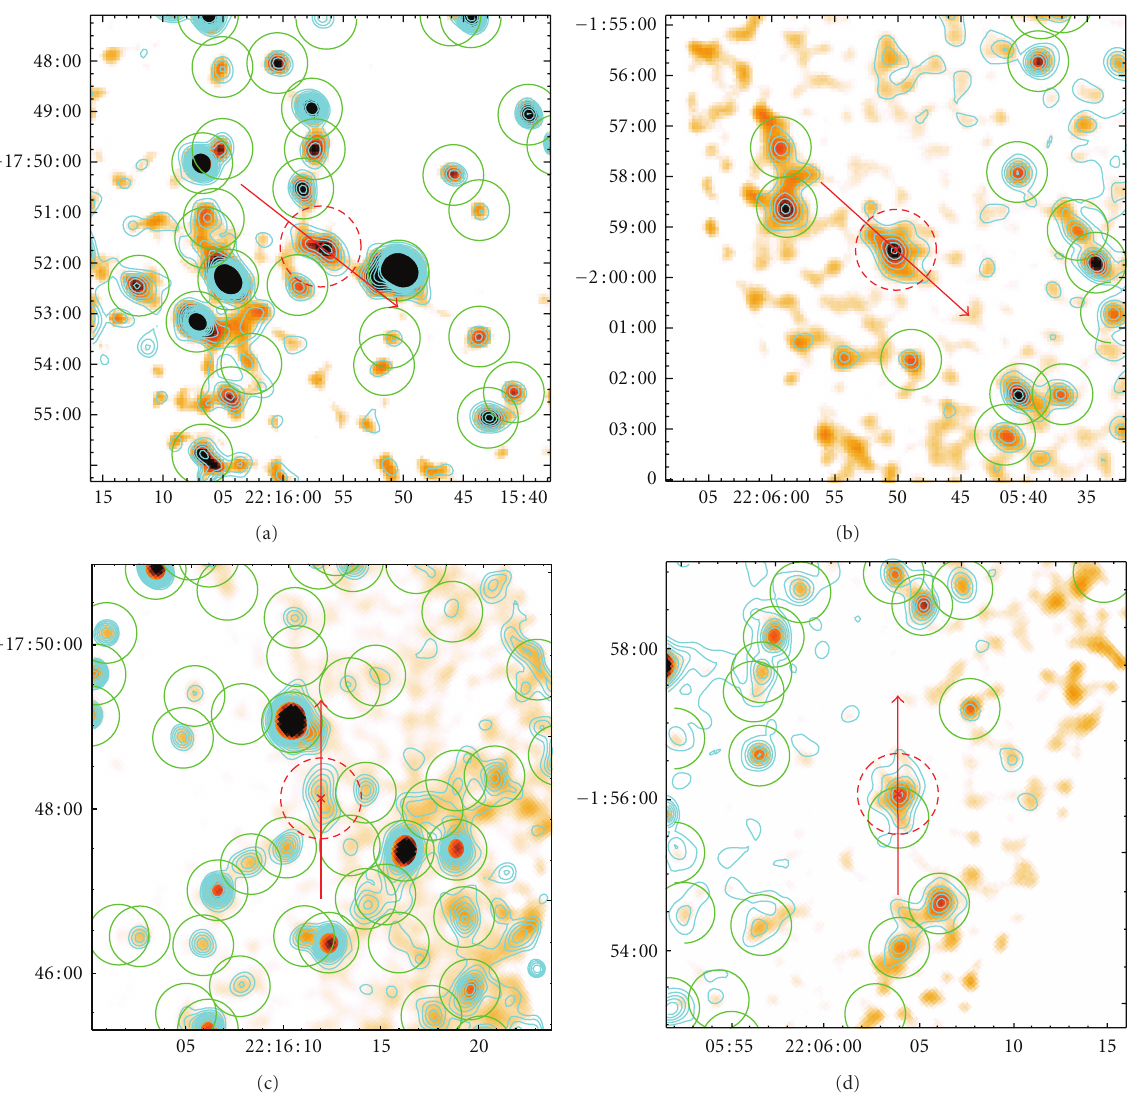
Figure 2: Close-up examples of the stacking process for the 9.2 (cid:3) × 9.2 (cid:3) cluster environments of XDCP J2215.9 − 1751 (C09) in the left panels and XDCP J2205.8 − 0159 (C12) in the right panels. Cluster positions are marked by red crosses and dashed circles, and the main elongation axis of the ICM emission is indicated by the red arrow with 2 (cid:3) length in both directions from the cluster centers. The top panels show the smoothed soft-band image and the 0.35–2.4 keV detected sources (green circles) in their original orientation (North up, East to the left). The bottom panels display the rotated images and detected sources in the full 0.3–7.5 keV energy range with rotation angles that align the cluster elongation axis in the North-South direction. All panels show overlaid the soft-band X-ray surface brightness contours in